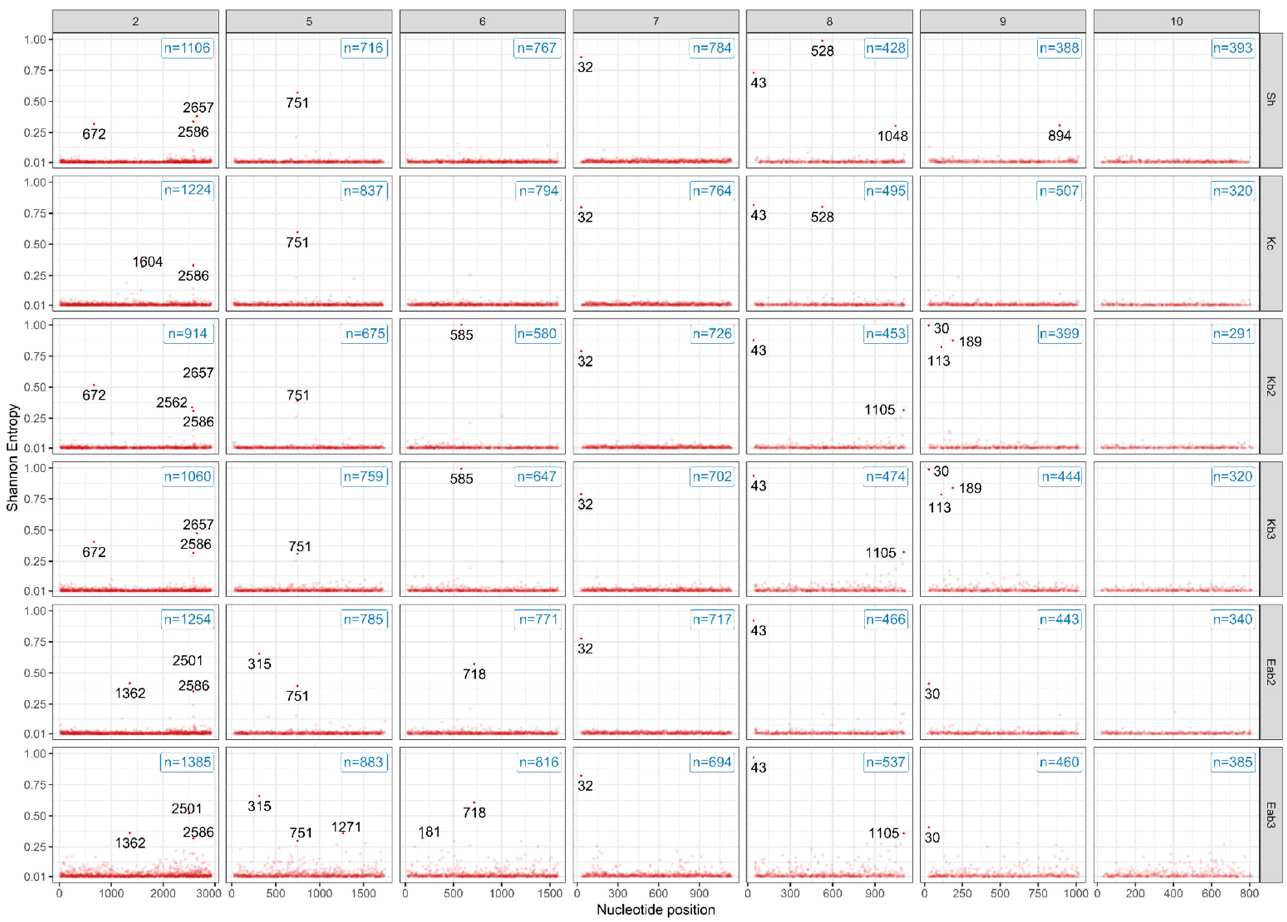
Figure 9. Shannon-entropy analysis of BTV-3 from infectious blood and cell-culture-passaged viruses. Deep sequencing was performed on amplicons of the genome segments shown. The y -axis represents nucleotide positions and the x -axis represents Shannon-entropy values. Nucleotide positions are indicated by a pink dot if the Shannon entropy value for that position is > 0.3. Total count of nucleotide positions achieving entropy > 0.01 are shown in the boxes on the top right. Kb = KC/BHK-BSR; Eab = ECE/ Aedes /BHK-BSR.